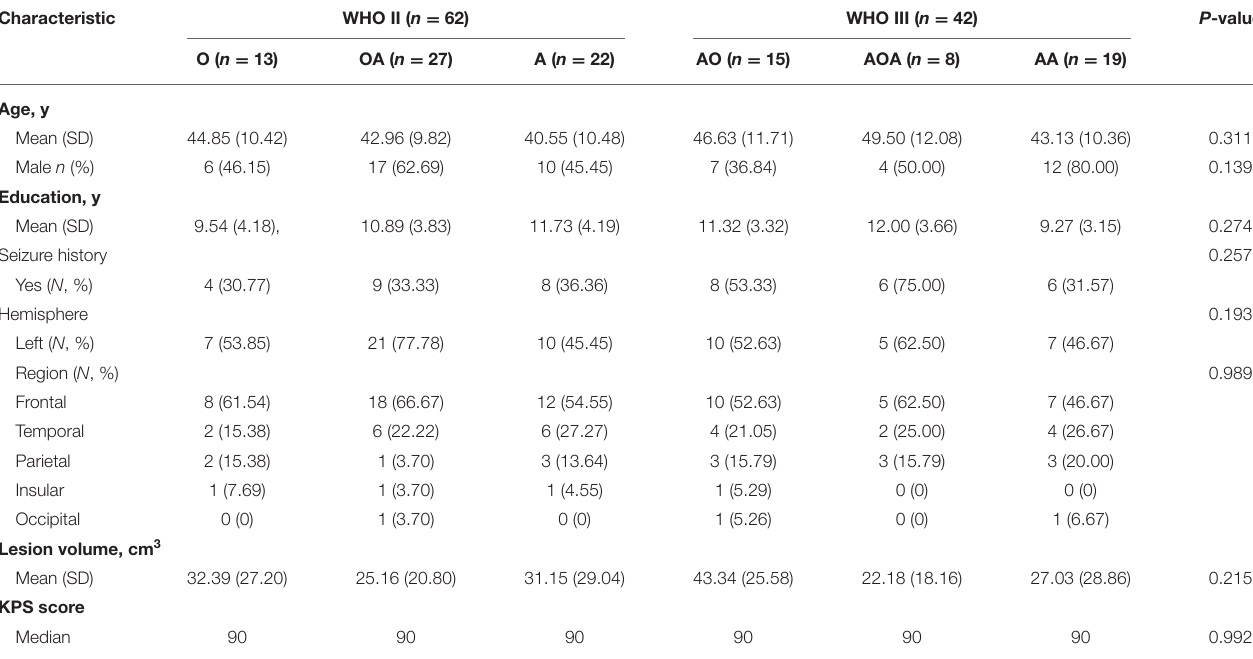
TABLE 4 | Clinical characteristics of morphologic